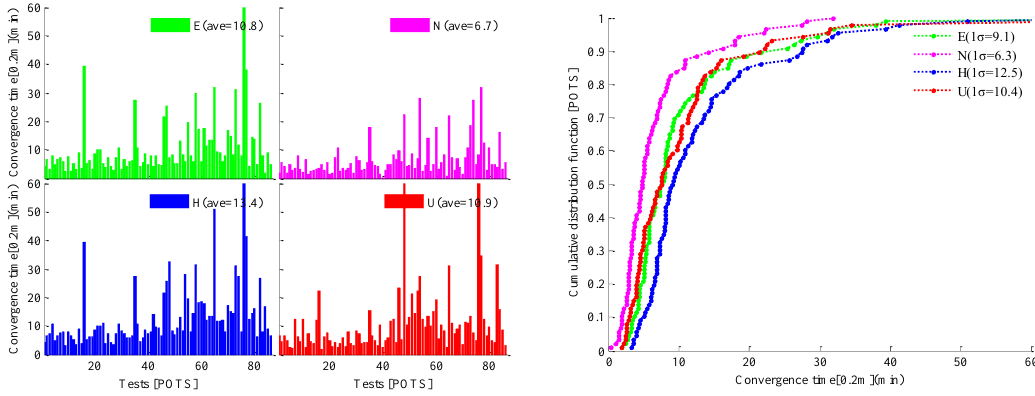
Figure 5. The convergence time for the 20-cm level for POTS ( left : bar series; right : CDF curve).